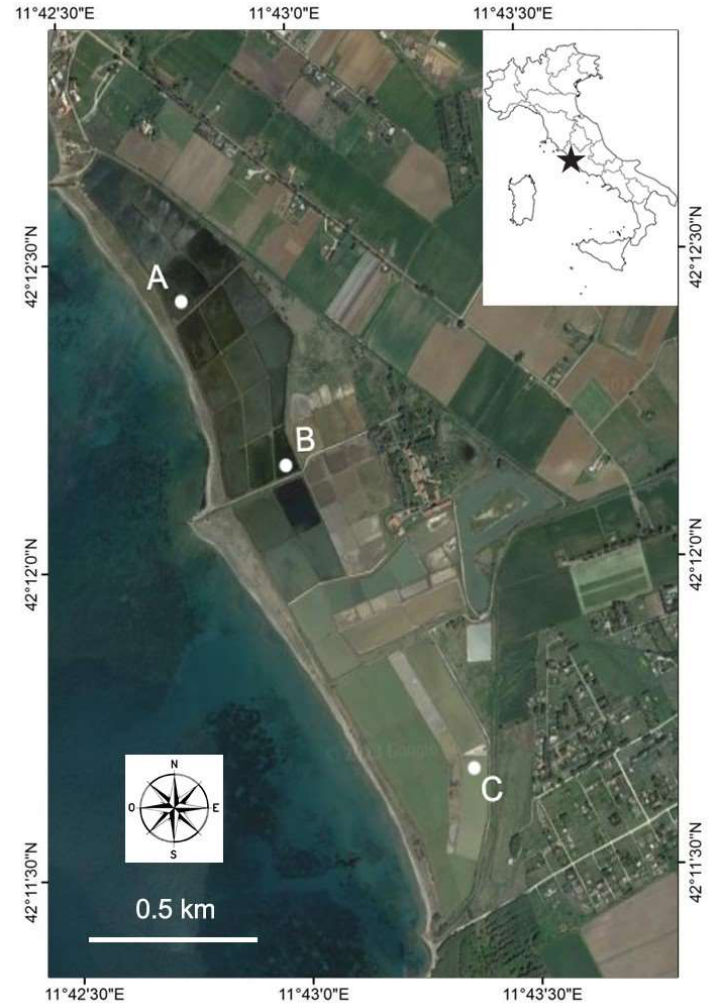
Figure 1. Location of sampling sites (A, B, and C) in the Saline di Tarquinia salterns. The symbol in the top-right map indicates the location of the study site. Image source: Google Earth.